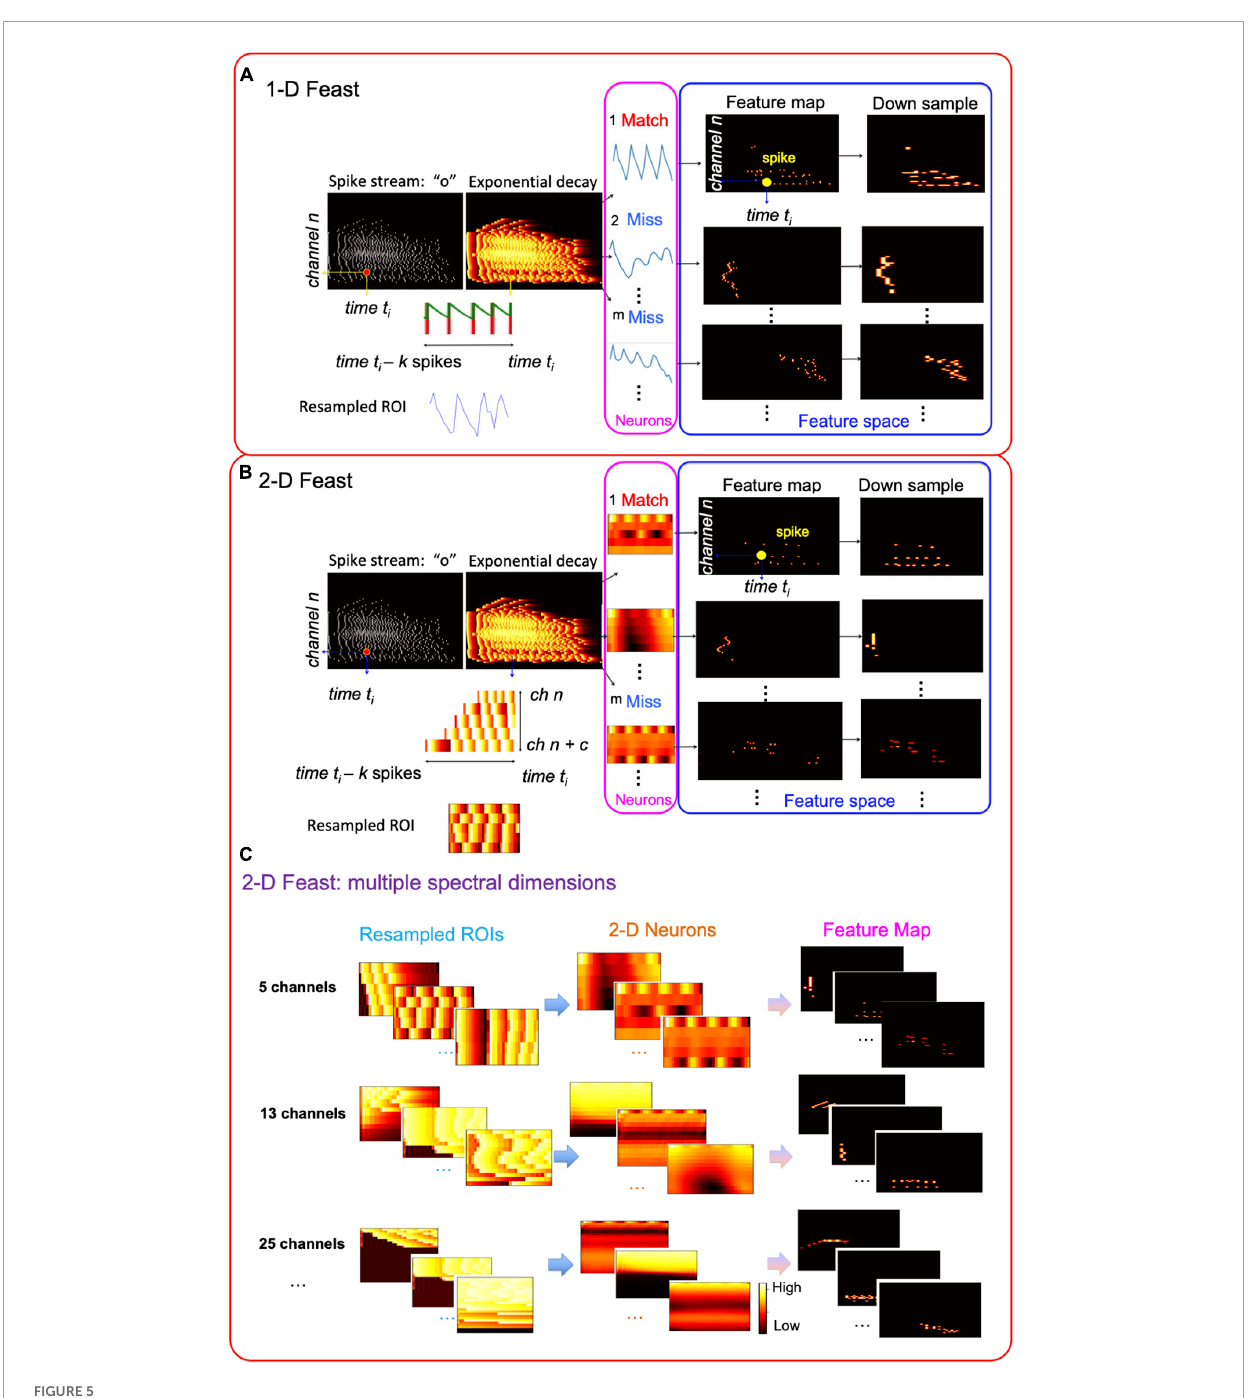
FIGURE5 Event-based spectrotemporal feature extraction: (A) 1-D FEAST; (B) 2-D FEAST; (C) 2-D FEAST on multiple spectral dimensions.